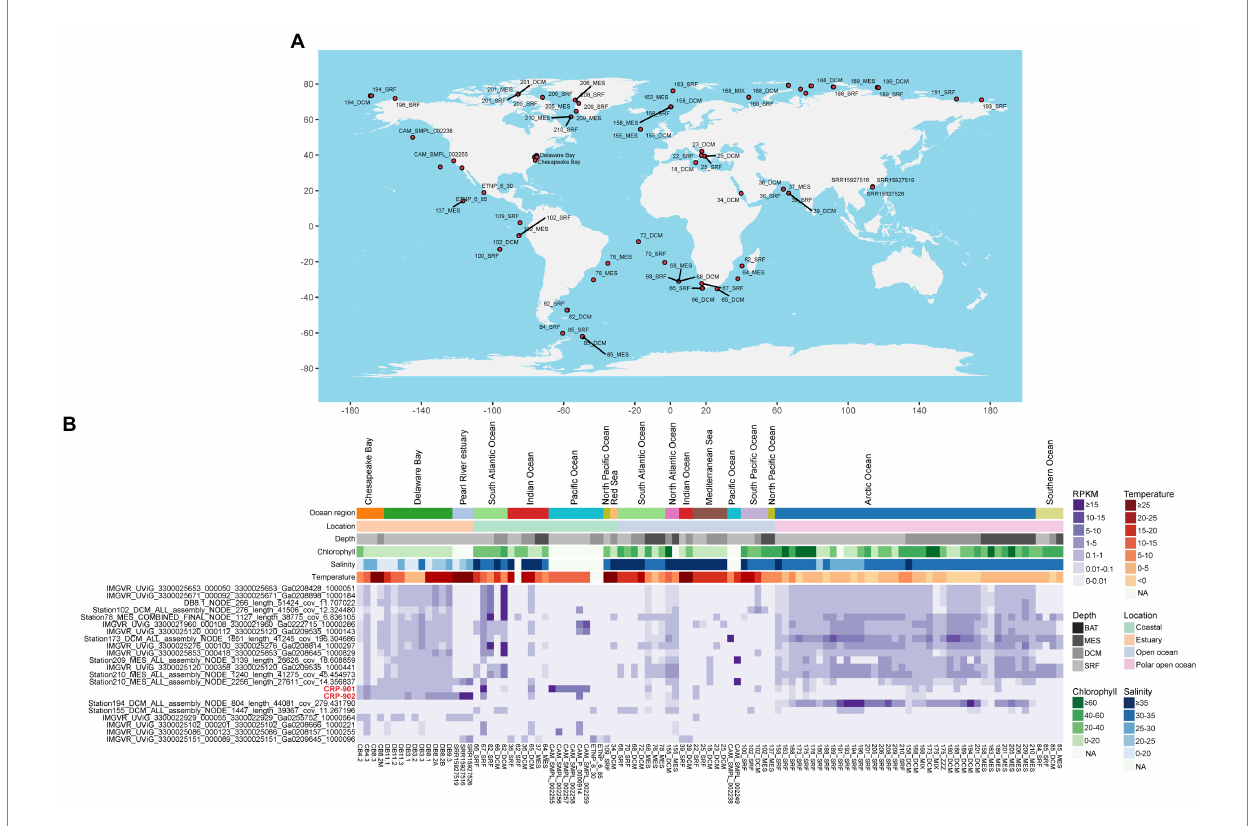
FIGURE 4 Global distribution and relative abundance of CRP-901-type phages in marine viromes. (A) Global distribution profile of the CRP-901-type phage group in marine viromes. The stations where CRP-901-type phages have been detected are shown with red circles. Phages were considered present only if their genome coverage was >20% in the data set. (B) The relative abundance of CRP-901-type phages at the species level in different marine viromes. The relative abundance of phages was normalized as the mapped read counts per kilobase pair of genomes per million read counts in the metagenome